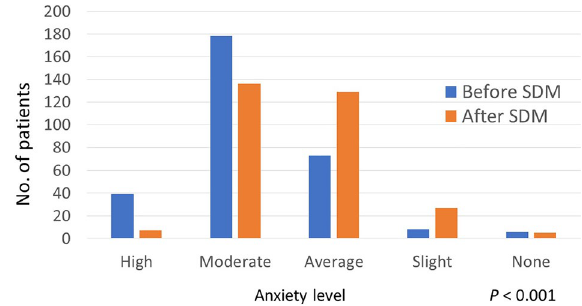
Figure 2. Comparison of anxiety level before and after SDM.